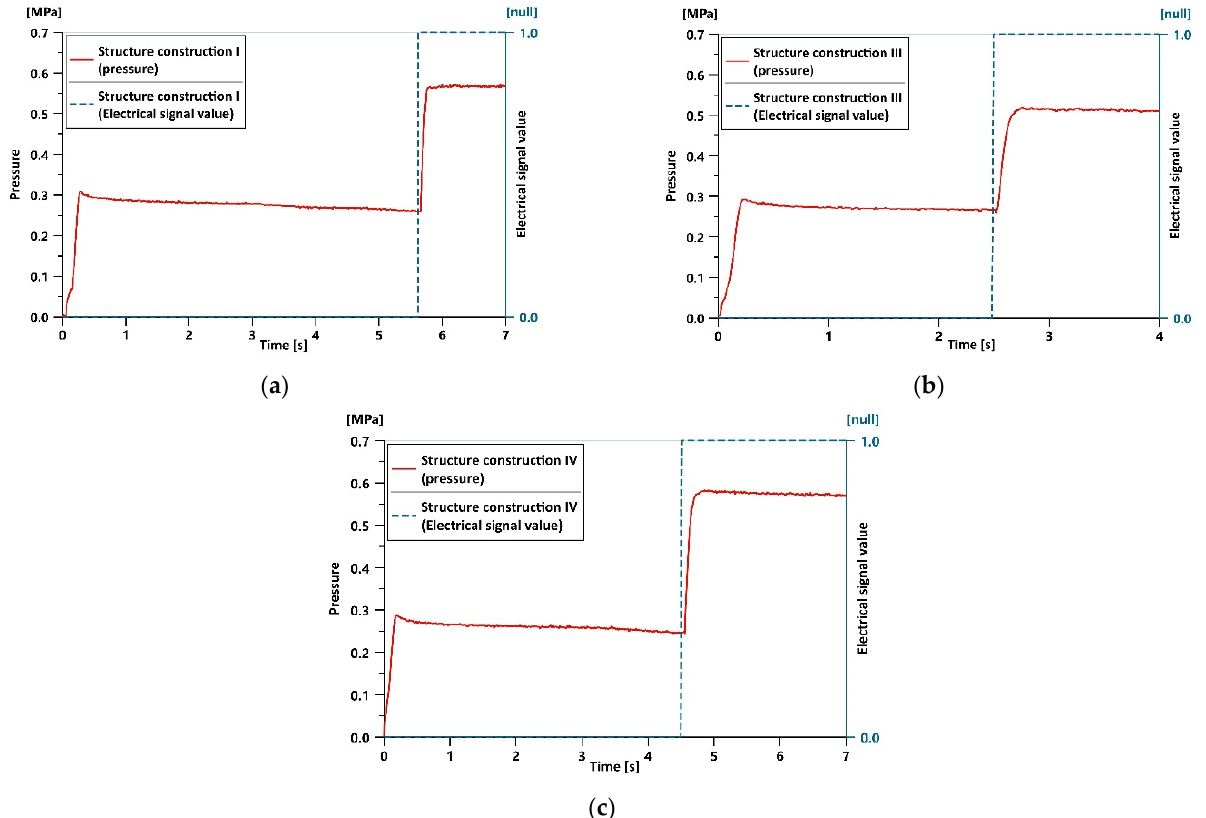
Figure 11. Results of the switch test between the manual and coupled control modes during pressurization: ( a ) structural configuration I, ( b ) structural configuration III and ( c ) structural configuration IV.